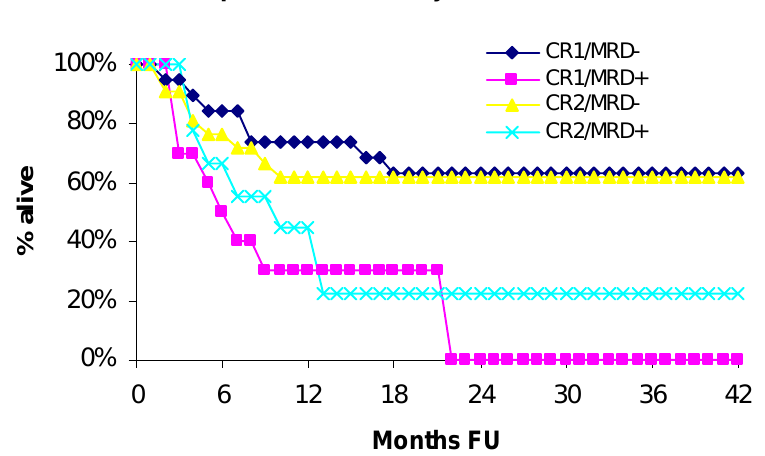
Figure 1. Overall survival by CR and